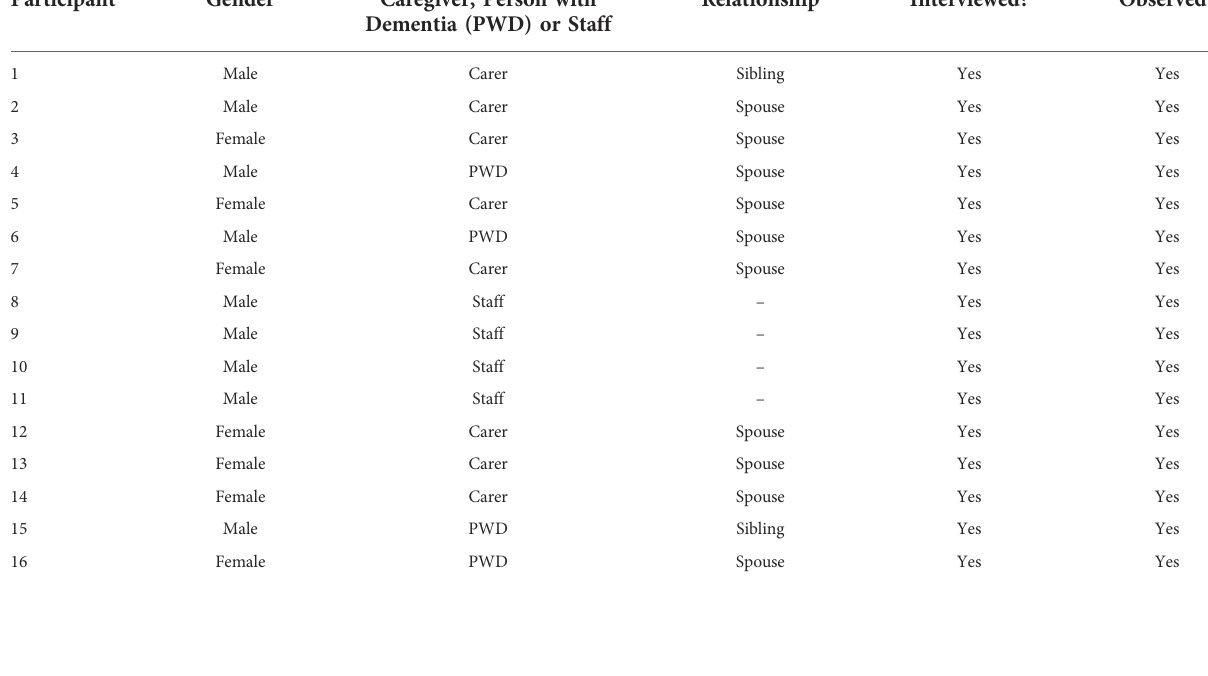
TABLE 2 Participant characteristics.